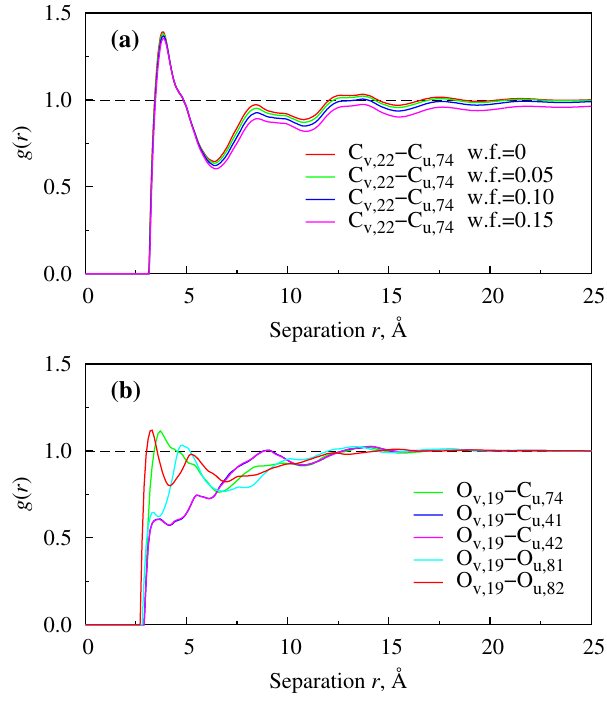
Figure 4. RDFs for X v –Y u interaction sites where X v belongs to P3HT ( a ) or P3BT ( b ) and Y u belongs to PCBM, at 400 K. Numerical labels of interaction sites can be found in Supplementary Materials (SM).